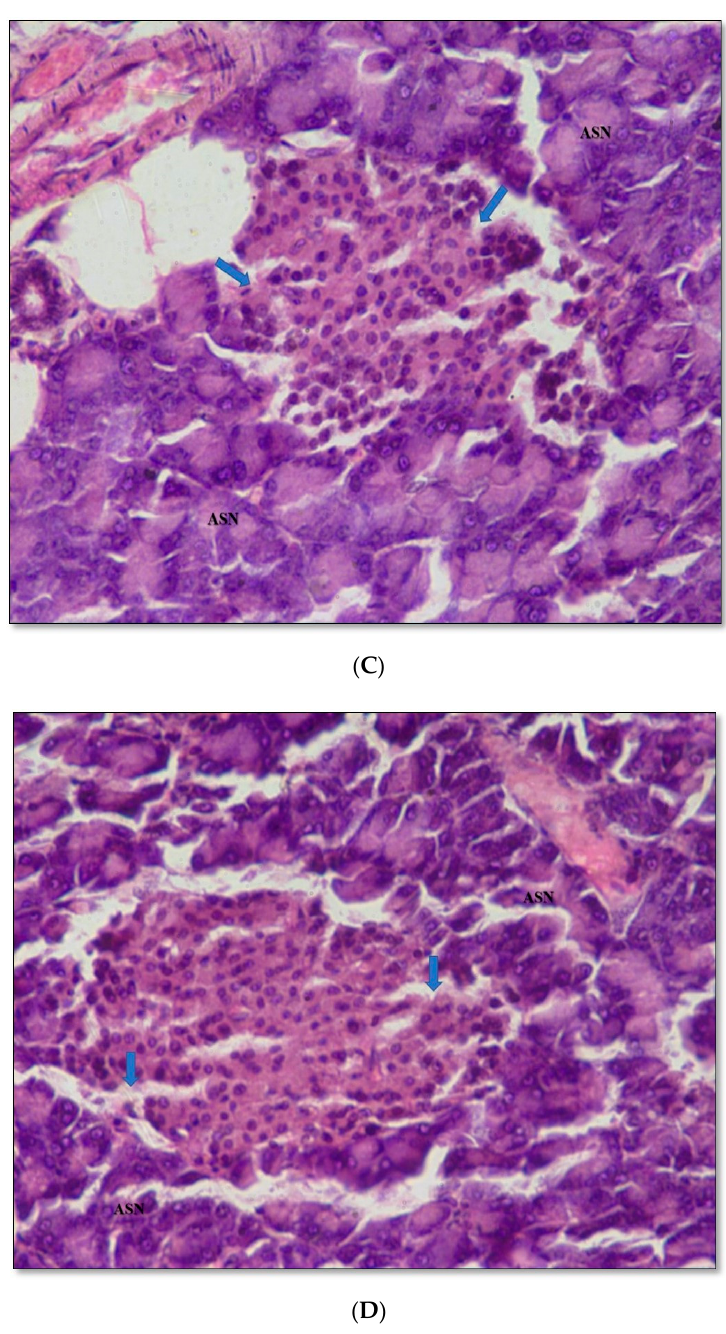
Figure 9. ( A ) Histopathology of a pancreas ( 400X HE) from an untreated non-diabetic rat (control): The arrows indicate a cellular mass of normal peripheral β -cells (PBC), distribution in islet (ISLT), and normal morphology of the arranged acini (ASN). ( B ) Histopathology of a T2DM control pancreas ( 400X HE) in untreated diabetic rats. The arrows indicate peripheral β -cells, rounded arrow indicates a congestion of RBC and the star indicates a vacuolated area in the pancreatic islet (ISLT) cells with abnormal appearance of the nucleus and abnormally arranged acini (ASN). ( C ) Histopathology of the pancreas of diabetic rats treated with an extract derived from DBT34 strain extract ( 400X HE): The arrows indicate a recovery of normal looking peripheral β -cells in islet (ISLT) and an increased cellular mass with normally arranged acini. ( D ) Histopathology of a pancreas of diabetic rats treated with sitagliptin ( 400X HE): The arrows indicate the regeneration of a damaged area of peripheral β -cells (PBC) and a compact arrangement of acini.